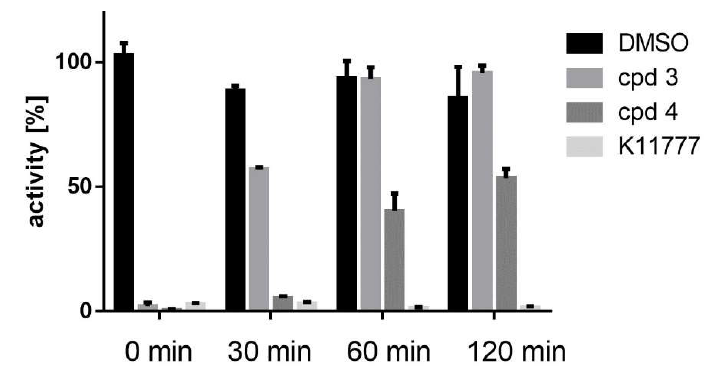
Figure 6. Dialysis assay to investigate the reversibility of the inhibition. Rhodesain was preincubated (30 min) with inhibitor 3 , 4 or K11777, respectively, (20 times the IC 50 concentration). Then, the mixture was dialyzed in a self-made dialysis chamber [35]. The enzyme activity of all samples was determined relatively to the DMSO treated sample (0 min) by a fluorometric enzyme assay. Both acids were found to inhibit both enzymes, cathepsin L and rhodesain, reversibly (Figure 6), but time-dependently (Figure 7A,C,E; see Tables 1 and 2 for detailed kinetic data). Dissociation constants K i and K i* , the rate constants k 3 and k 4 and the half-lives t 1/2 and reaction energies ΔE reac were obtained as described above (see Table 2, see exemplarily Figure 7 for inhibition of cathepsin L by compound 4 , and rhodesain by compounds 3 and 4 ).